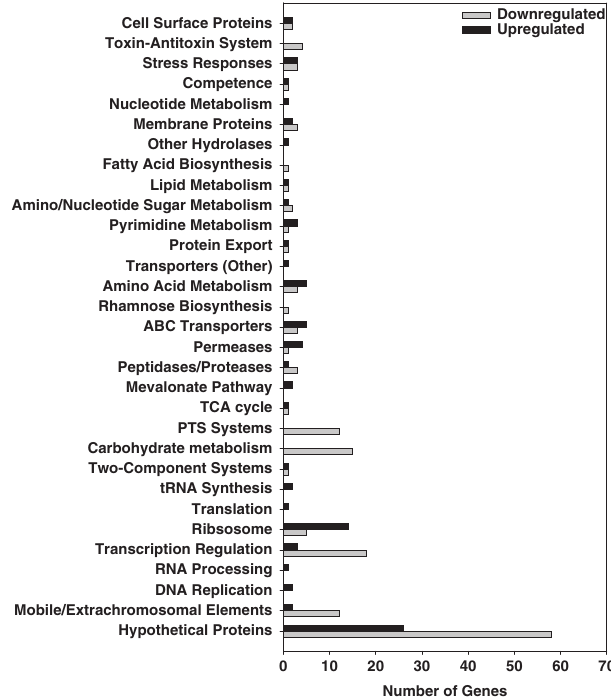
Fig. 4 Distribution of gene functional categories differentially expressed during normal gravity growth relative to simulated microgravity. RNA isolated from 8 h normal gravity and simulated microgravity S. mutans HARV cultures ( n = 3 independent experi- ments per growth condition) was subjected to RNA-seq transcrip- tome pro fi ling as described in “ Materials and methods ” . Differential expression and statistical analysis was carried out using a cutoff FDR-adjusted p value of 0.05. Of this dataset, those genes with a log 2 (fold-change) value of at least ± 1.0 were grouped by functional classi fi cation based on DAVID gene functional categorization analysis, NCBI gene annotations and KEGG pathway analysis. Total number of up-regulated genes (log 2 fold-change ≥ 1.0, black bars ) = 94, total number of down-regulated genes (log 2 fold-change ≤ − 1.0, gray bars ) =